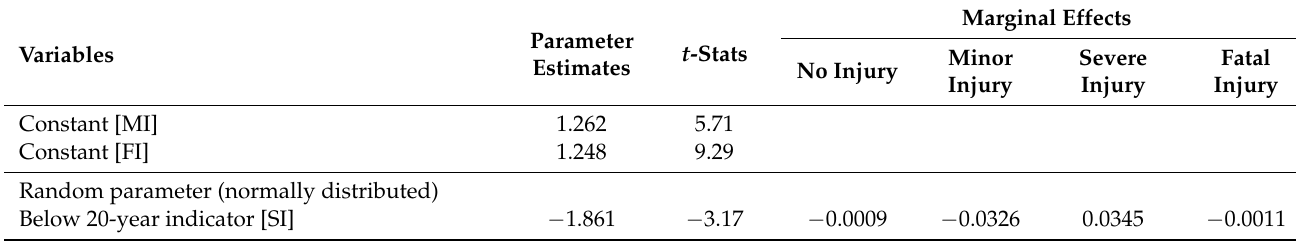
Table 8. Model estimation results for helmet-wearing motorcycle crashes